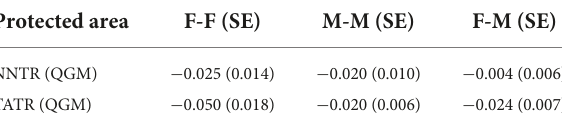
TABLE 4 Mean relatedness between the same-sex and opposite-sex pairs of individual dhole genotypes of Nawegaon-Nagzira Tiger Reserve (NNTR) and Tadoba-Andhari Tiger Reserve (TATR) using Queller–Goodnight